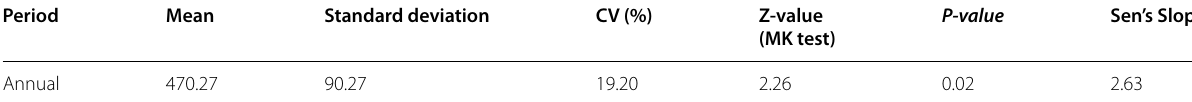
Table 5 Descriptive statistics and test results of annual rainfall (1981–2018) Period